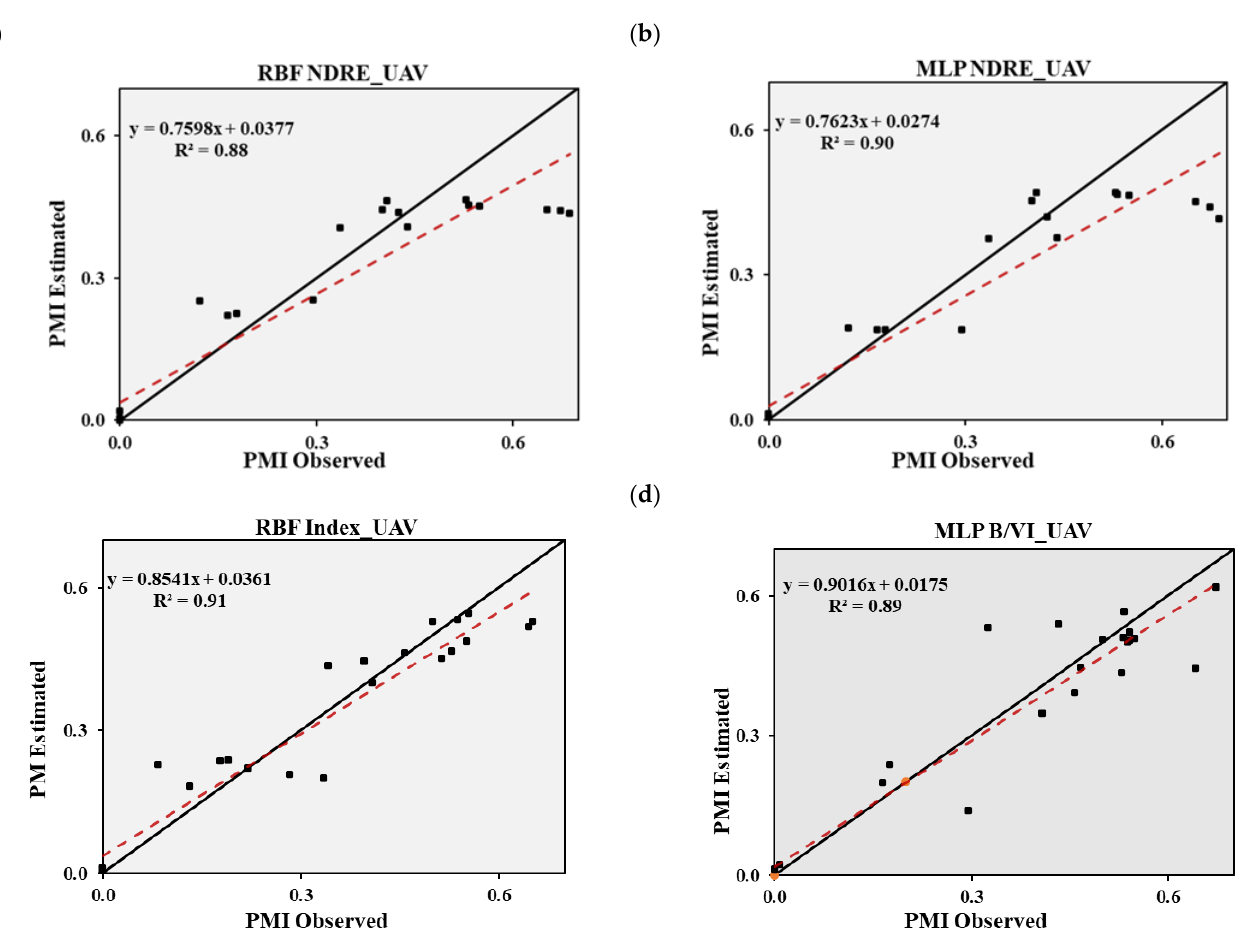
Figure 5. Performance of the satellite data for the models using the variables that showed the best accuracy (MAE) for the two neural networks (RBF and MLP). ( a , c , e , g ) refer to models with the RBF network, while the letters ( b , d , f , h ) refer to models of the MLP network.